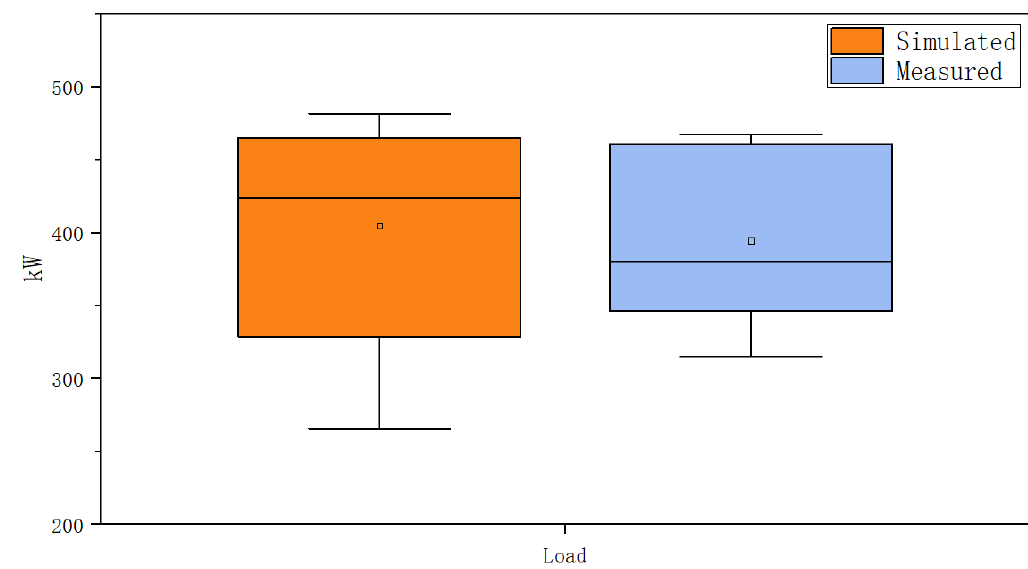
Figure 13. Comparison result of simulated value and measured value of total load.